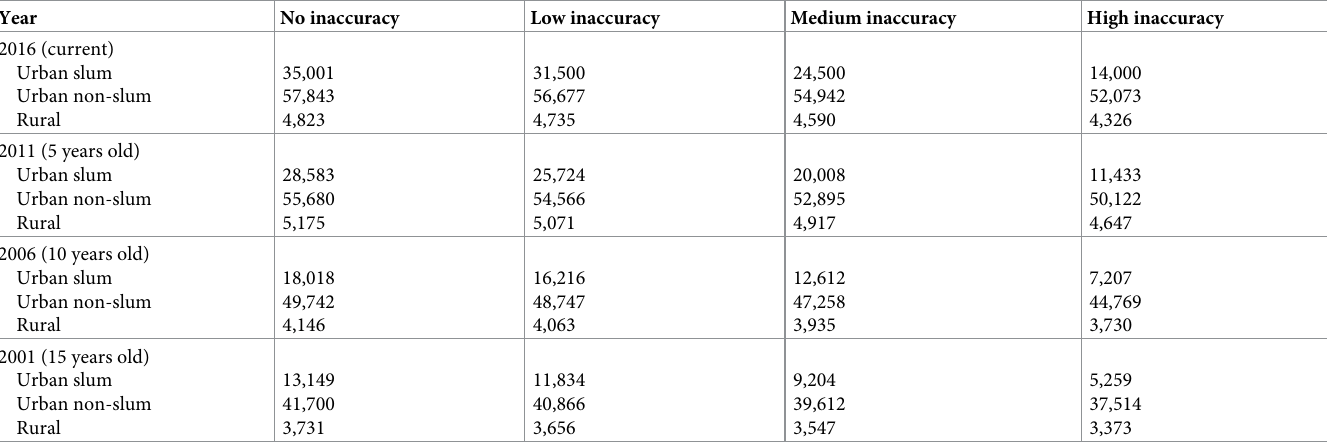
Table 2. Number of households simulated in the "true" synthetic population and 15 realistic scenarios of census outdatedness and inaccuracy, by household type.